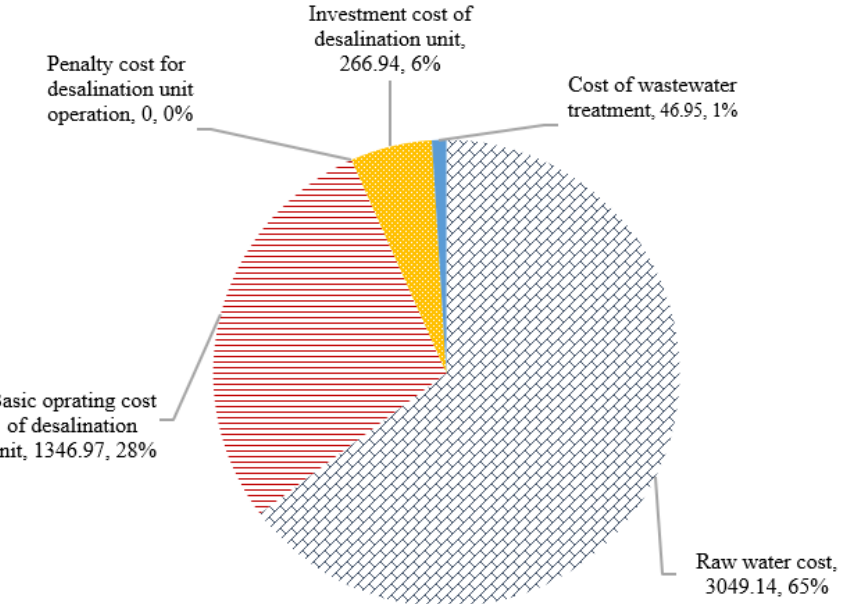
Figure 2. Optimal water supply network (Scenario 1).